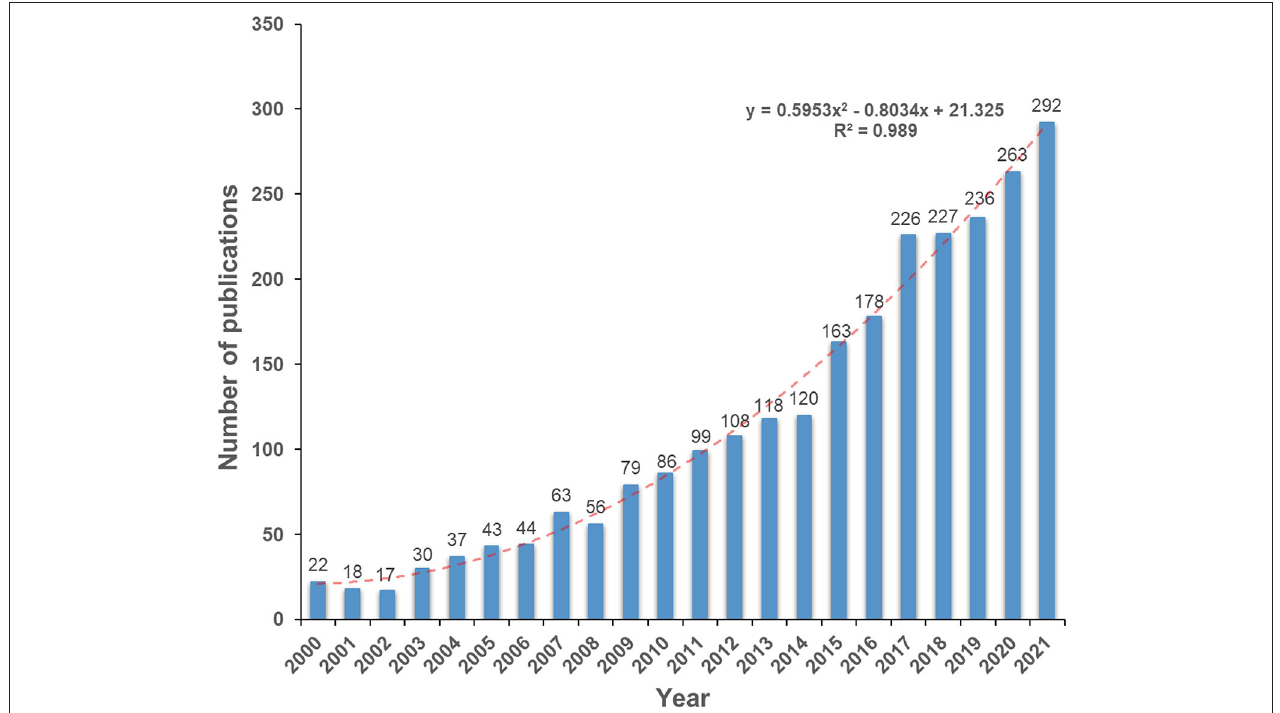
FIGURE 2 | The specific amount of annual publications regarding BMDM from 2000 to 2021.